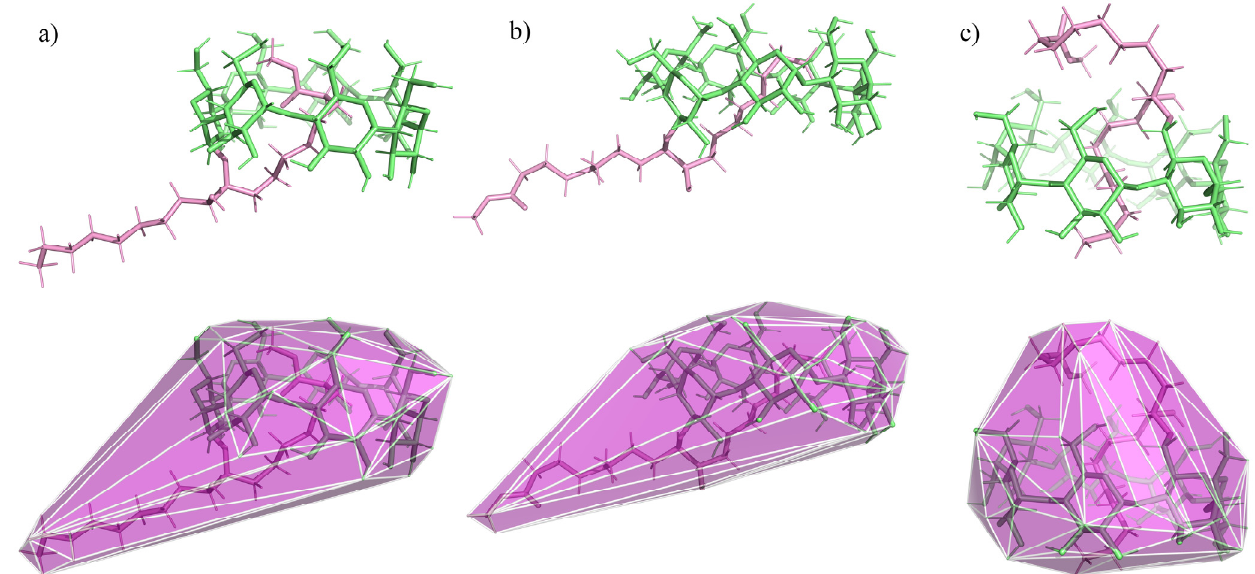
Figure 3. Representative structures of Lip β CD substituted in a ) position 2, Lip β CD(OH 2 ), b ) position 3 Lip β CD(OH 3 ) and c ) position 6, Lip β CD(OH 6 ).